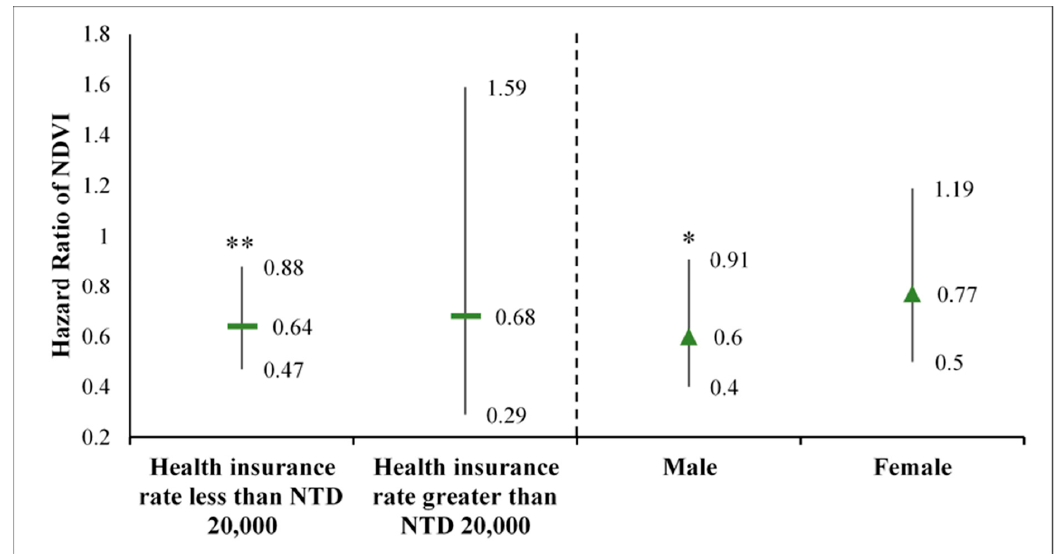
Figure 2. Stratified analysis for the hazard ratio of NDVI (estimates with 95% confidence interval) according to sex and health insurance rate less (poorer) than NTD 20,000 and health insurance rate greater than NTD 20,000 (richer). Significance level: * indicates p value < 0.05, ** indicates p value < 0.01, and *** indicates p value < 0.001